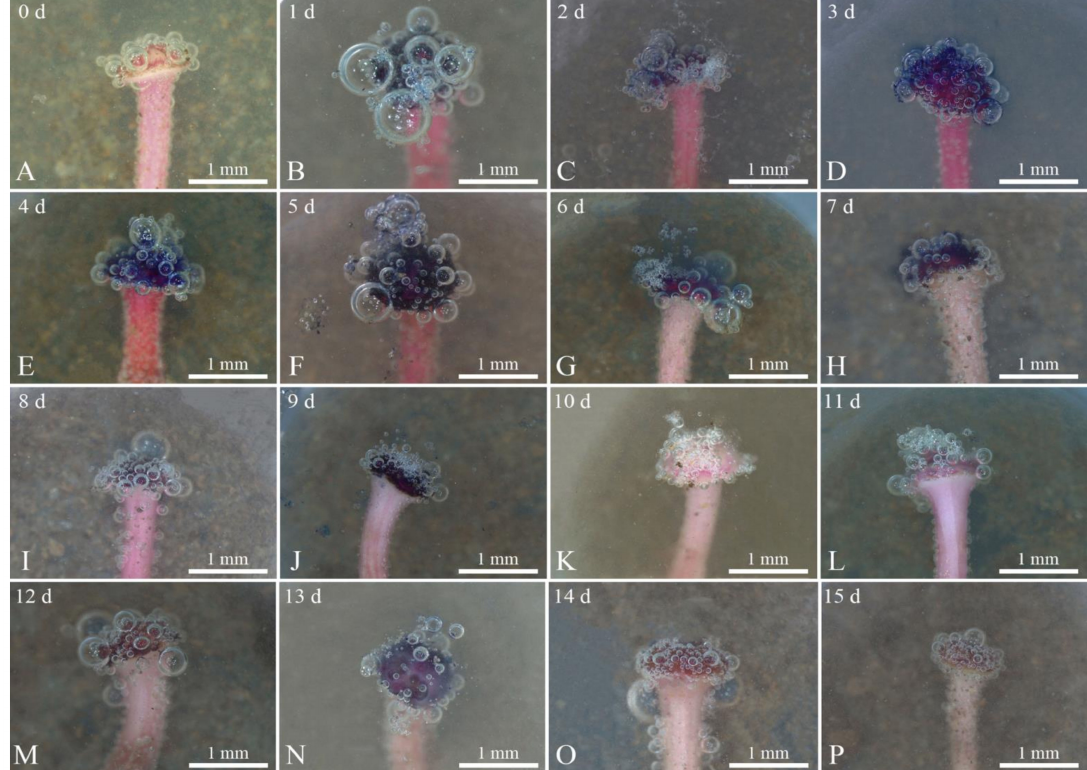
Figure 7. Detection of stigma receptivity under a stereomicroscope using the benzidine-hydrogen peroxide method. ( A